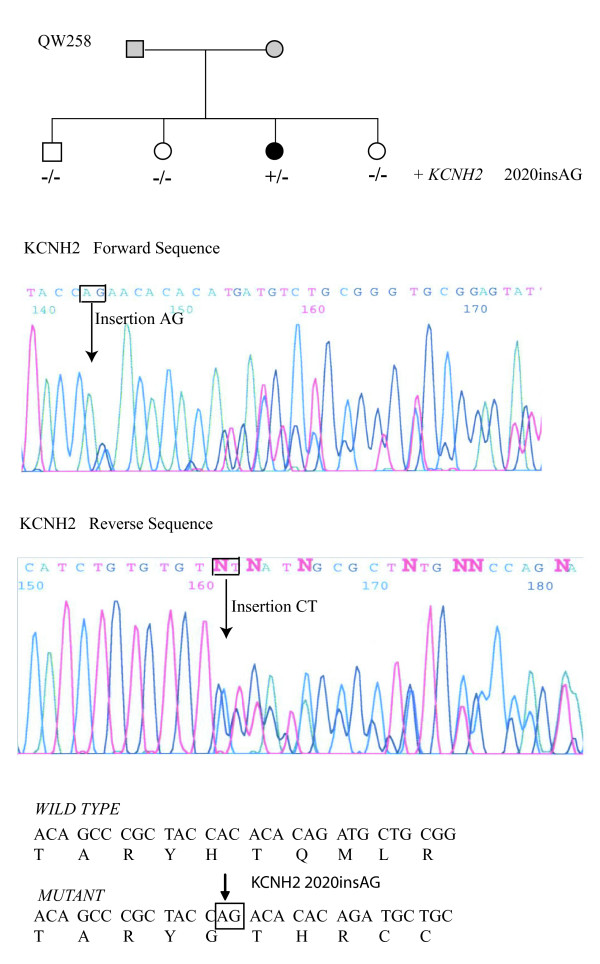
Identification of a novel mutation in KCNH2, 2020insAG, in family QW258. Top, pedigree structure; Middle, DNA sequence for the patient using the forward primer; Bottom, DNA sequence for the patient using the reverse primer.